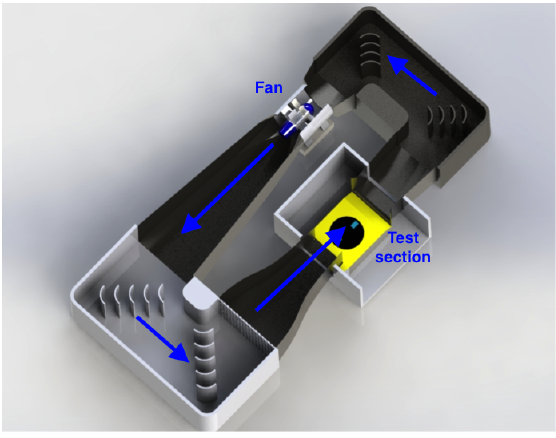
Figure 3. The wind tunnel.